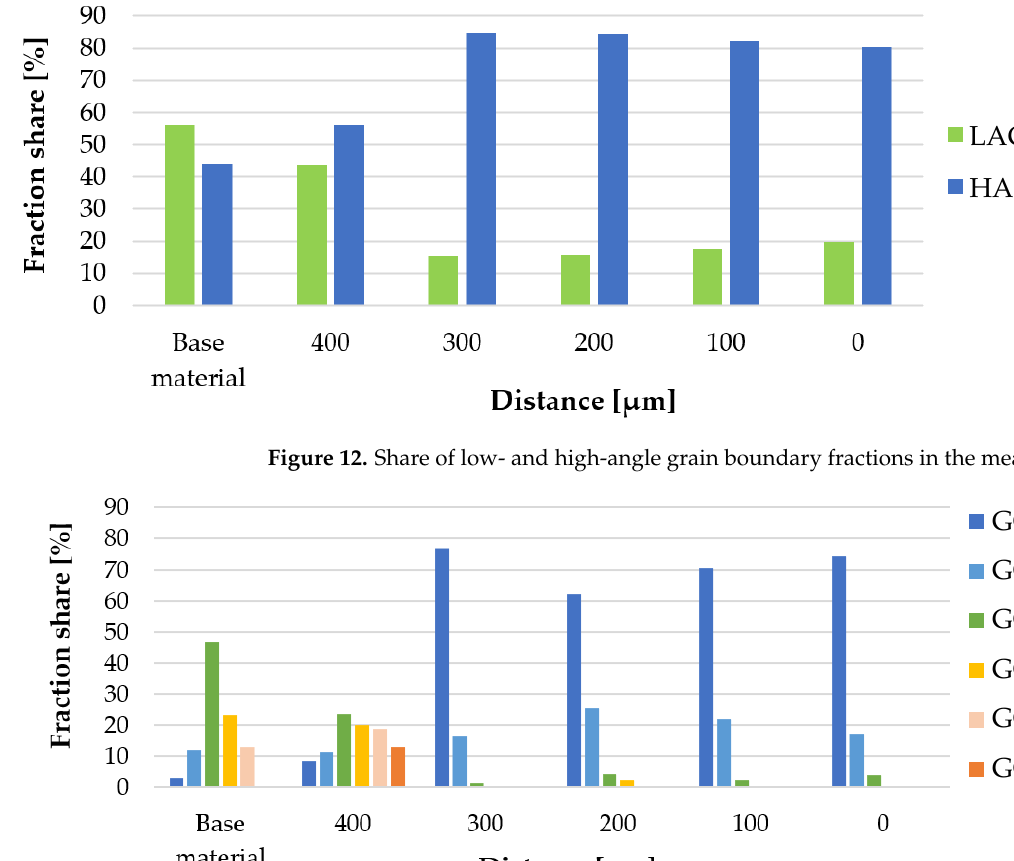
Figure 11. Distribution of the mean grain size obtained in the measurement areas.